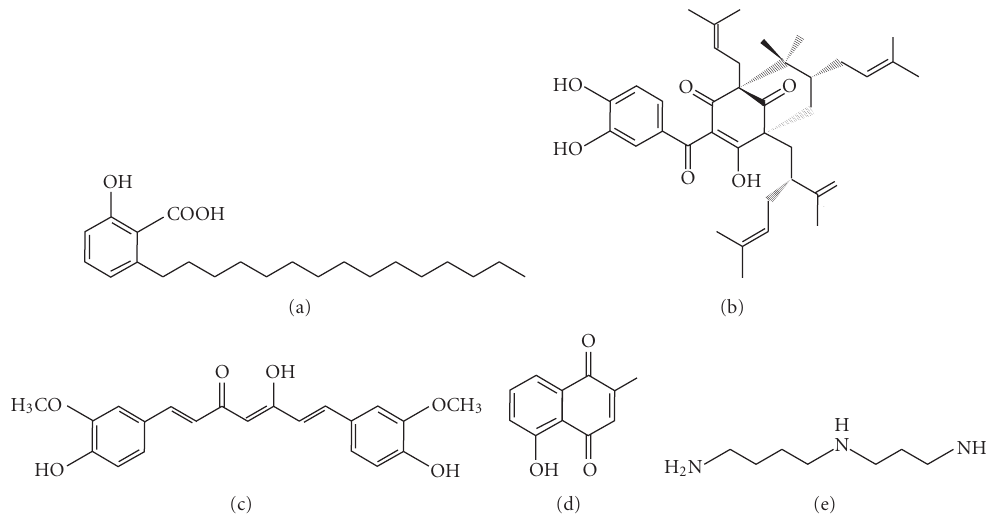
Figure 3: Chemical structure of naturally occurring KAT inhibitors. (a) Anacardic acid from cashew nut shell extracts; (b) garcinol from Garcinia indica fruit rind; (c) curcumin from Curcuma longa rhizome; (d) plumbagin from Plumbago rosea root extracts; and (e) spermidine as an endogenous molecule [28, 32, 33]. Some of these compounds have been modified to synthesize more enzyme-specific inhibitors, which are not depicted here [34,